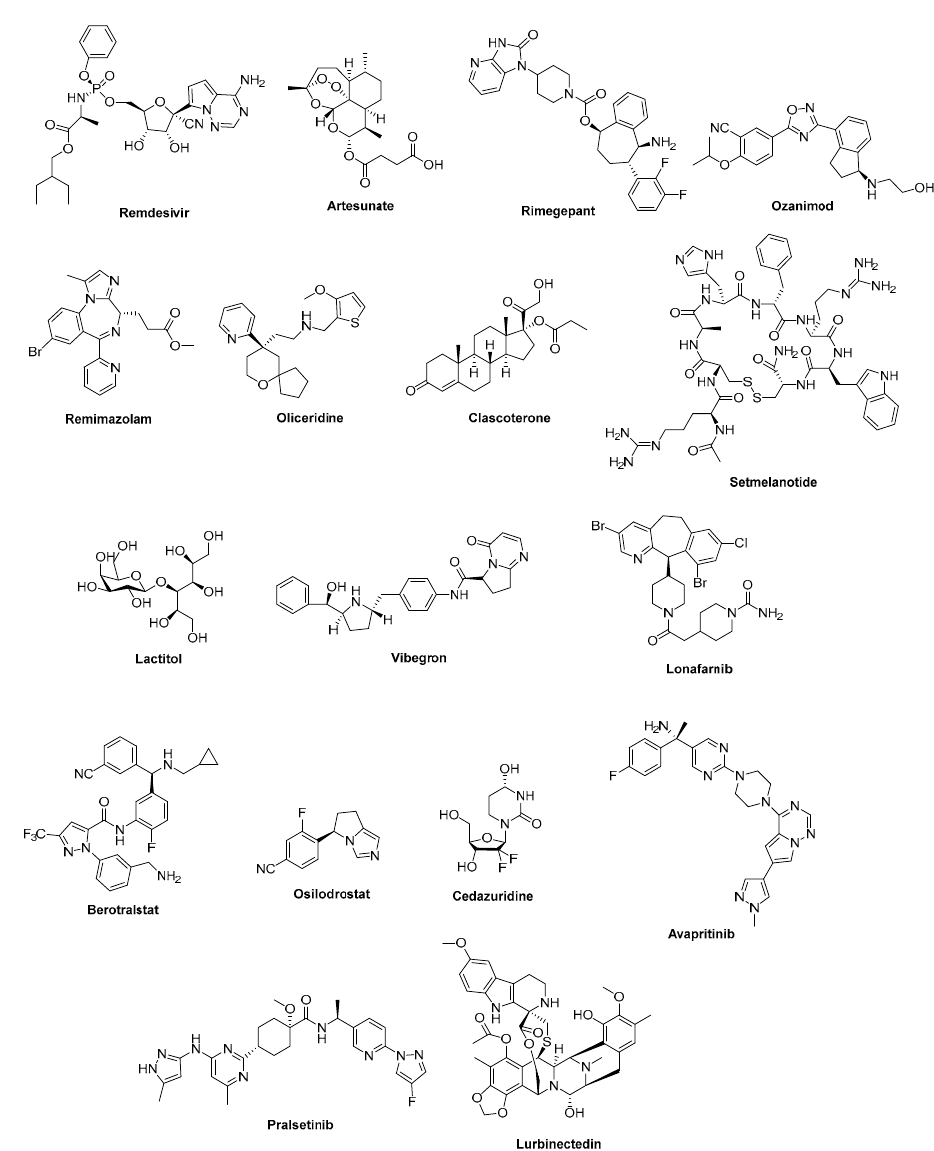
Figure 6. Structure of chiral drugs approved in 2020.